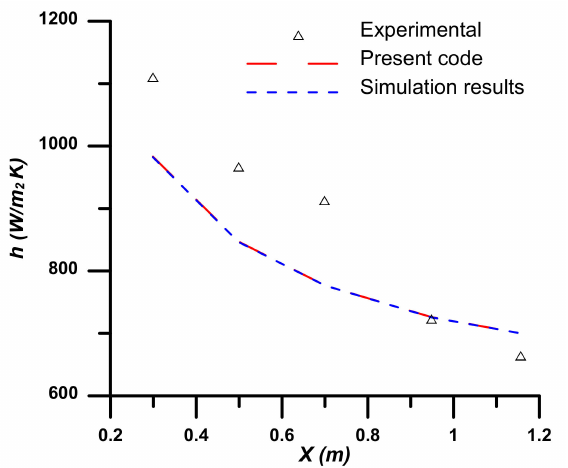
Figure 2. Validation of the present code local heat transfer coefficient with experimental [33] and simulation work